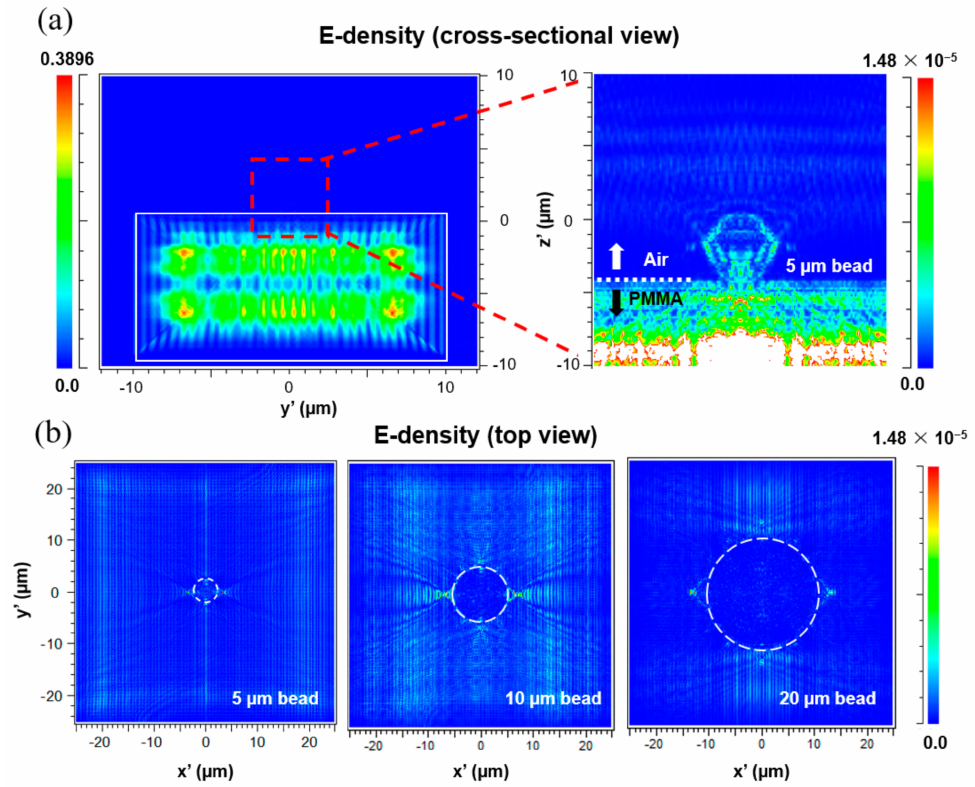
Figure 2. Electromagnetic field distribution of the side − illuminated TIR platform. Energy density plots from cross − sectional view ( a ) and top view ( b ). The TIR effect could be well observed inside of the PMMA plate, and four boundaries of microbeads showed concentrated energy compared to the other